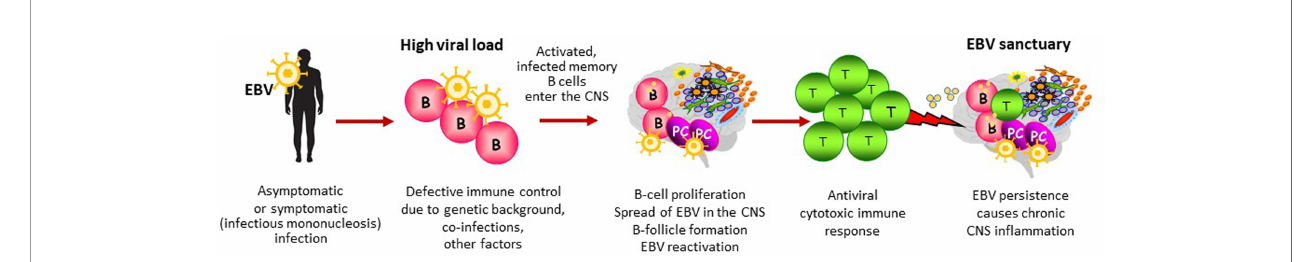
FIGURE 3 | EBV-driven immunopathological model of MS. This fi gure depicts the main steps potentially leading to establishment of an abnormal EBV infection in the CNS and the ensuing immunopathological response. In individuals at risk of developing MS, defective immune control of the virus could be determined by a high viral load at primary infection (infectious mononucleosis), genetic in fl uences on immune system function, coincident infections and/or any other environmental factor affecting the host ’ s immune system status. In susceptible individuals, EBV-infected memory B cells could elude immune control and seed into the CNS where they would expand favouring EBV persistence and periodic EBV reactivation (the CNS as an EBV sanctuary). Though activated in the periphery, CNS-homing EBV speci fi c T cells do not clear the virus and become exhausted over time due to persistent, abnormal viral reactivation. The protective antiviral immune response turns into a dysfunctional immune response that promotes CNS in fl ammation and causes collateral neural